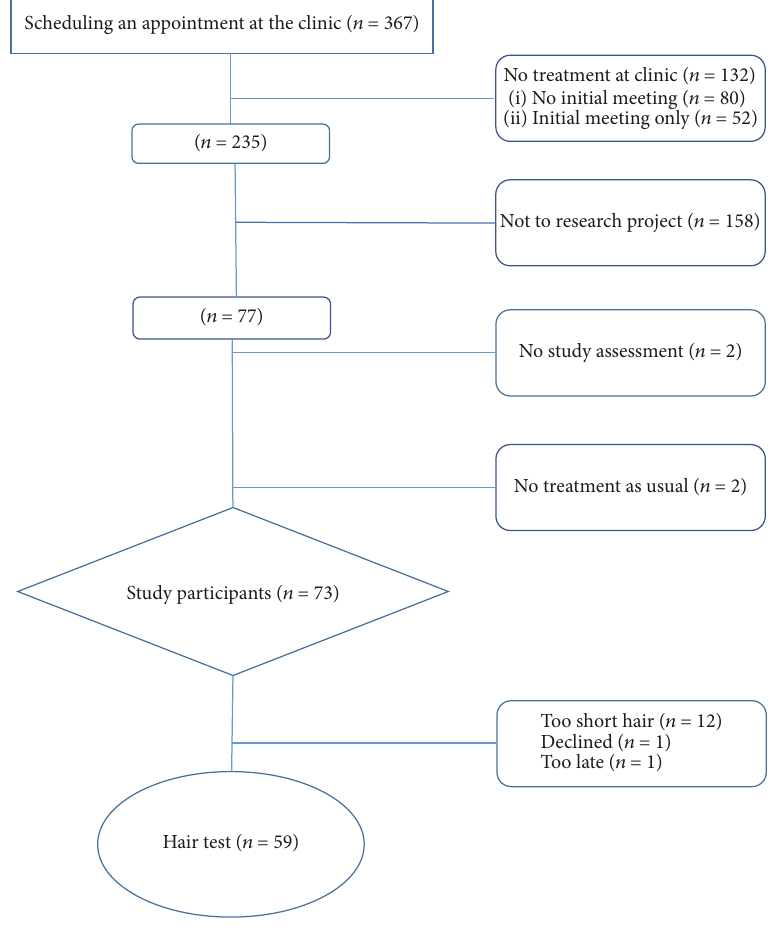
Figure 1: Flow chart of participants in the